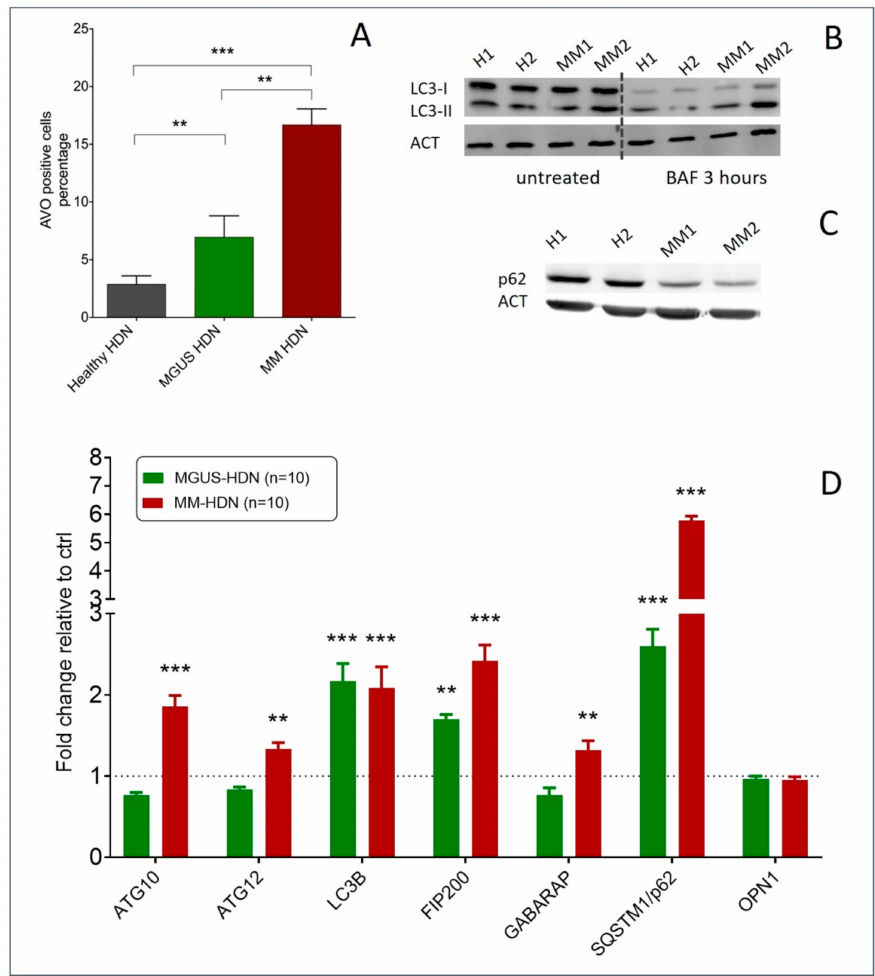
Figure 3. Autophagy is increased in MGUS and MM high-density neutrophils (HDNs). ( A ) The histograms show the average numbers and standard deviations of acidic vesicular organelles (AVOs) quantified by flow cytometry using acridine orange staining, in healthy ( N = 10), MGUS ( N = 10), and MM HDNs ( N = 10) processed within two hours from collection. ** p < 0.01, *** p < 0.001 (Student’s t -test and ANOVA test for multiple comparisons). ( B ) Representative immunoblot of endogenous unconjugated LC3-I to lipid-conjugated LC3-II in healthy and MM HDNs. Cells were treated for 3 h with 50 nM bafilomycin (BAF) or left untreated, lysed in 1% SDS, and analyzed by western blot with anti-LC3 Ab. ACT / actin served as a loading control throughout. ( C ) Representative immunoblot of p62 / SQSTM1 autophagy receptor in healthy and MM HDNs. ( D ) Quantitative RT-PCR analysis of fold-changes of transcripts encoding autophagy machinery and responsive proteins in healthy (given 1, dashed line), MGUS, and MM-HDN. *** p < 0.0001; ** p < 0.001 (Student’s t